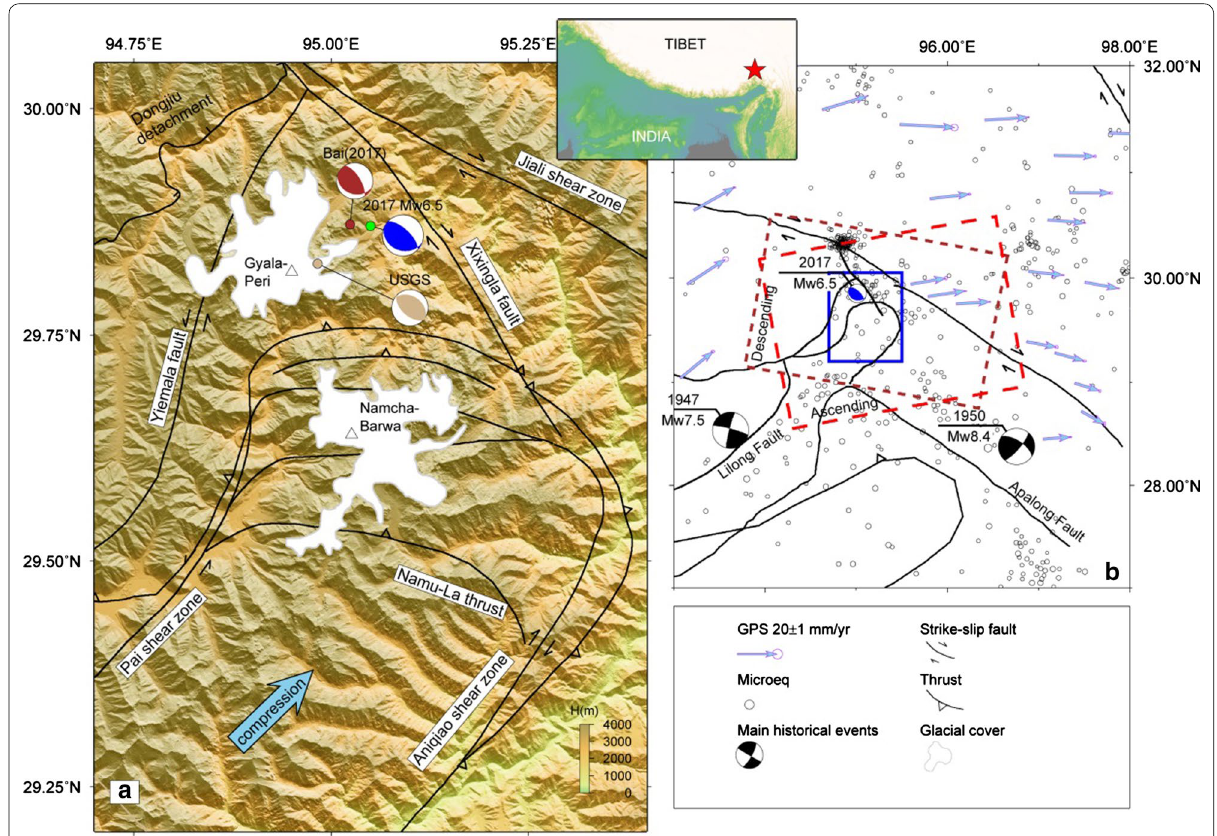
Fig. 1 a Tectonic map of the Namche Barwa syntaxis. The beach balls represent the location and the focal mechanism of the Mainling earthquake: The blue one is the result of this study, the green one is from the USGS, and the red one is from Bai et al. (2017). b Tectonic map and historical earthquakes ( M w > 4) around the Namche Barwa syntaxis. The locations and the focal mechanisms of the Mainling earthquake and the M w > 7 historical earthquakes are represented with the blue and black beach balls, respectively. The dotted line rectangles indicate the extents of the interferograms shown in Table 1. The blue box indicates the extent of Fig. 1a. Blue arrows are interseismic GPS velocities (from CMONOC, in a period of 1999–2017) provided by the GNSS Data, Products and Services Platform (http://www.cgps.ac.cn/) of the China Earthquake Administration.